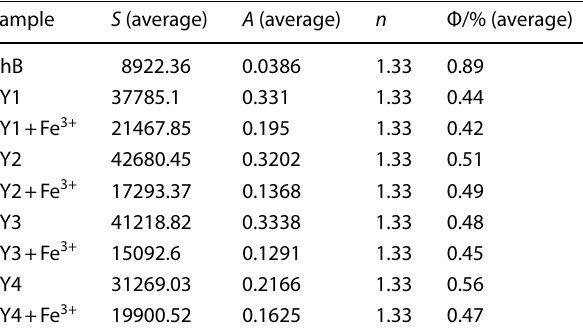
Table 3 Fluorescence quantum yield (Φ) before and after the poly- meric probes were combined with Fe 3+ Sample